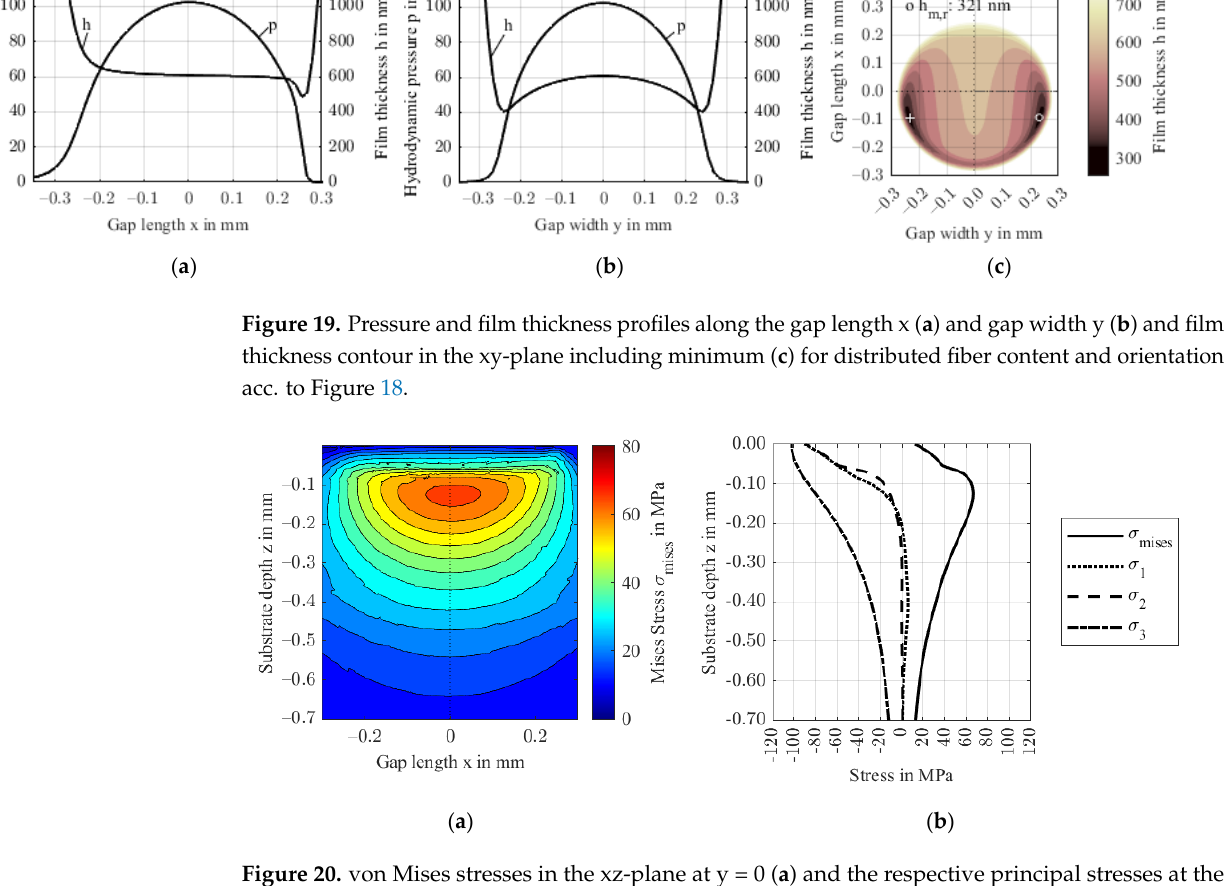
Figure 20. von Mises stresses in the xz-plane at y = 0 ( a ) and the respective principal stresses at the contact center of the FRP in substrate depth direction z ( b ).